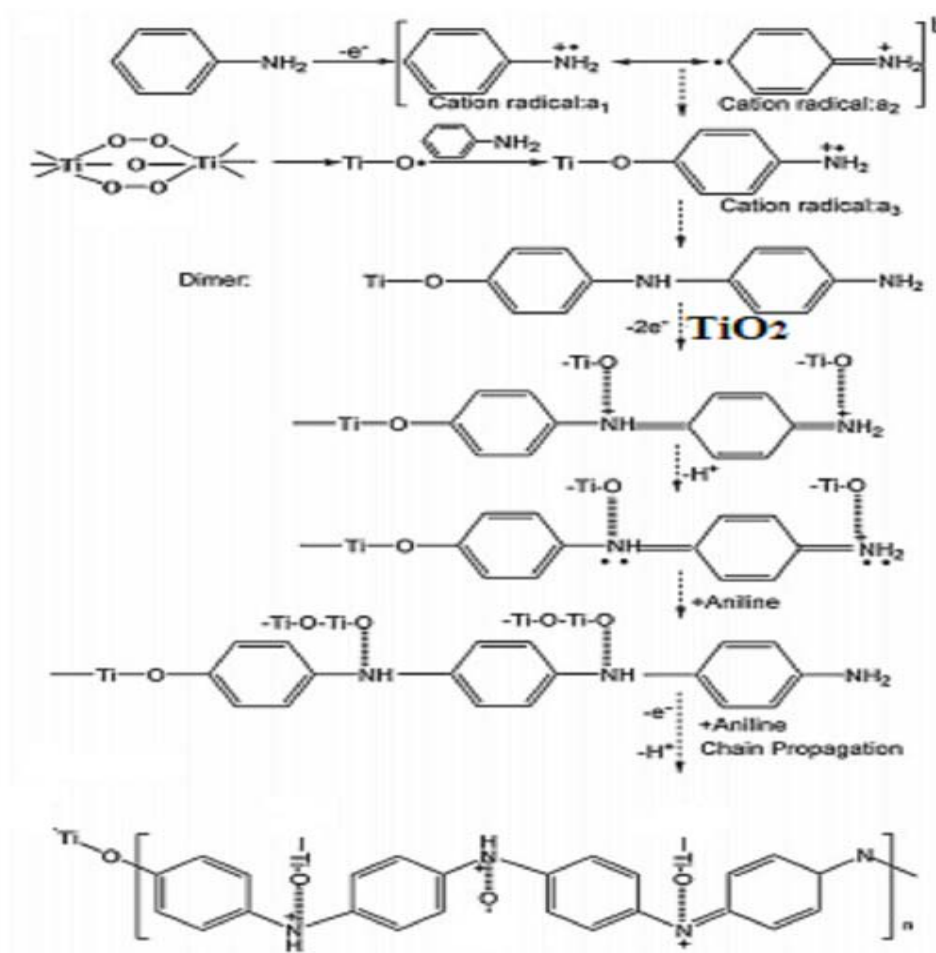
nanocomposite on AA3004. 2